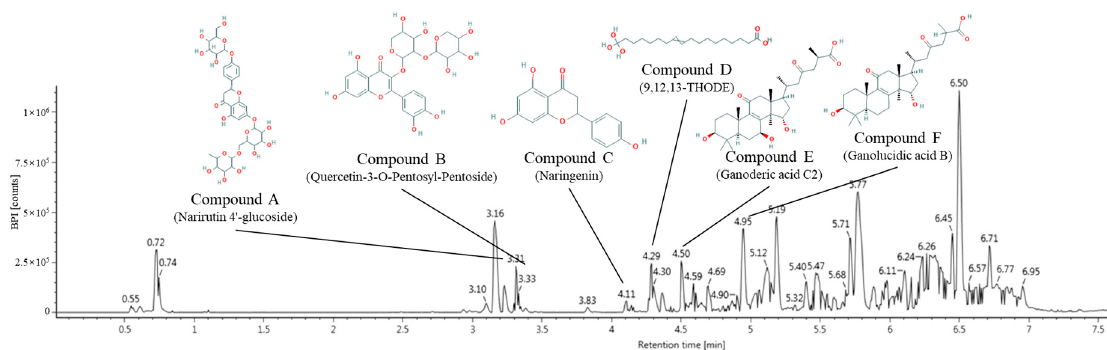
Figure 1. Q-TOF UPLC/MS chromatographic spectra in negative ion mode. Table 1. Compounds identified from green tea seed oil (GTO).